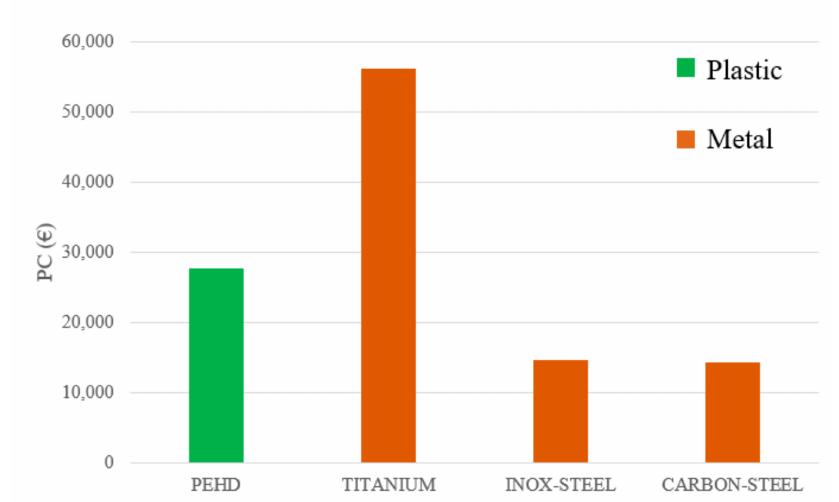
Figure 6. Length of tubes and purchase cost for di ff erent materials